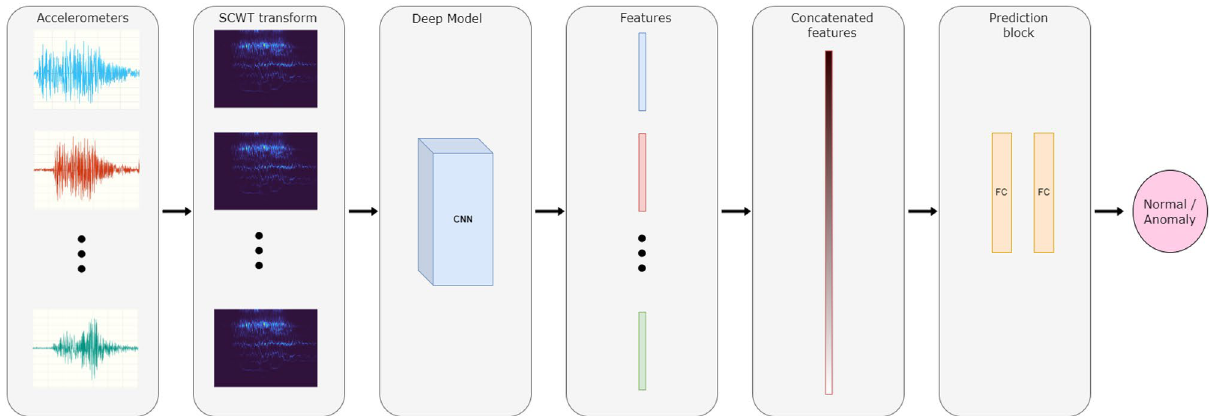
Figure 2. IADE proposed pipeline. The first block represents the raw input signals coming from the accelerometers, while the second block is showing the RGB image obtained by transforming the input with the SCWT function and turbo colormap. The remaining blocks depict the deep neural network module with the features accumulation step and the final binary